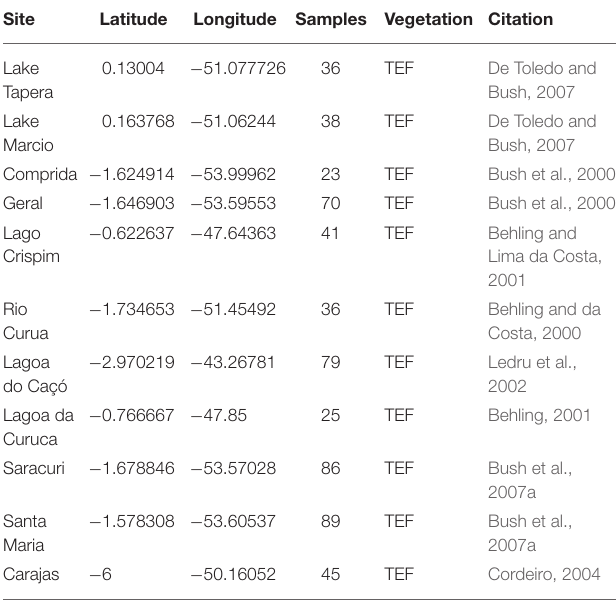
TABLE 2 | Existing charcoal records used for regional charcoal curve (RCC) from the eastern Amazon compiled from the Global Charcoal Database.